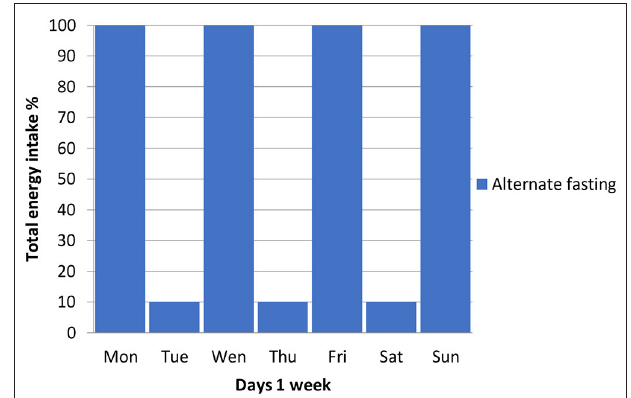
FIGURE 3 | Alternating 1:1